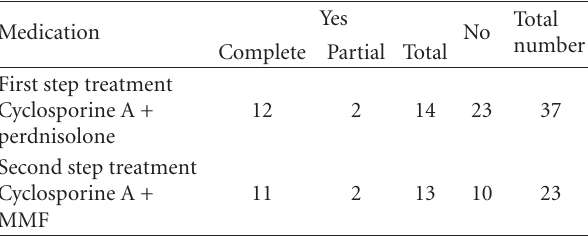
Table 2: Response of Nephrotic Syndrome to combination